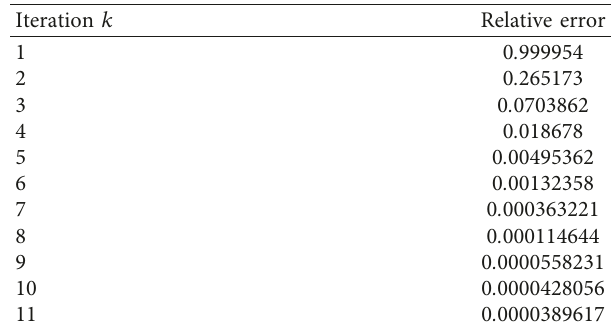
Figure 7: Relative error versus iteration k k � 6 ... 10. Table 1: Relative